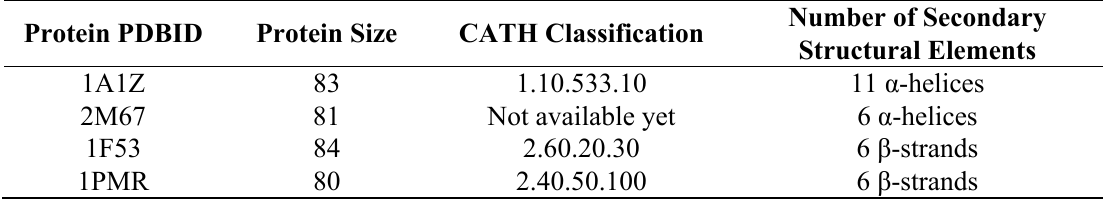
Table 11. List of four proteins that are used in establishing the properties of 2D-PDPA bb-rmsd interpretation patterns.